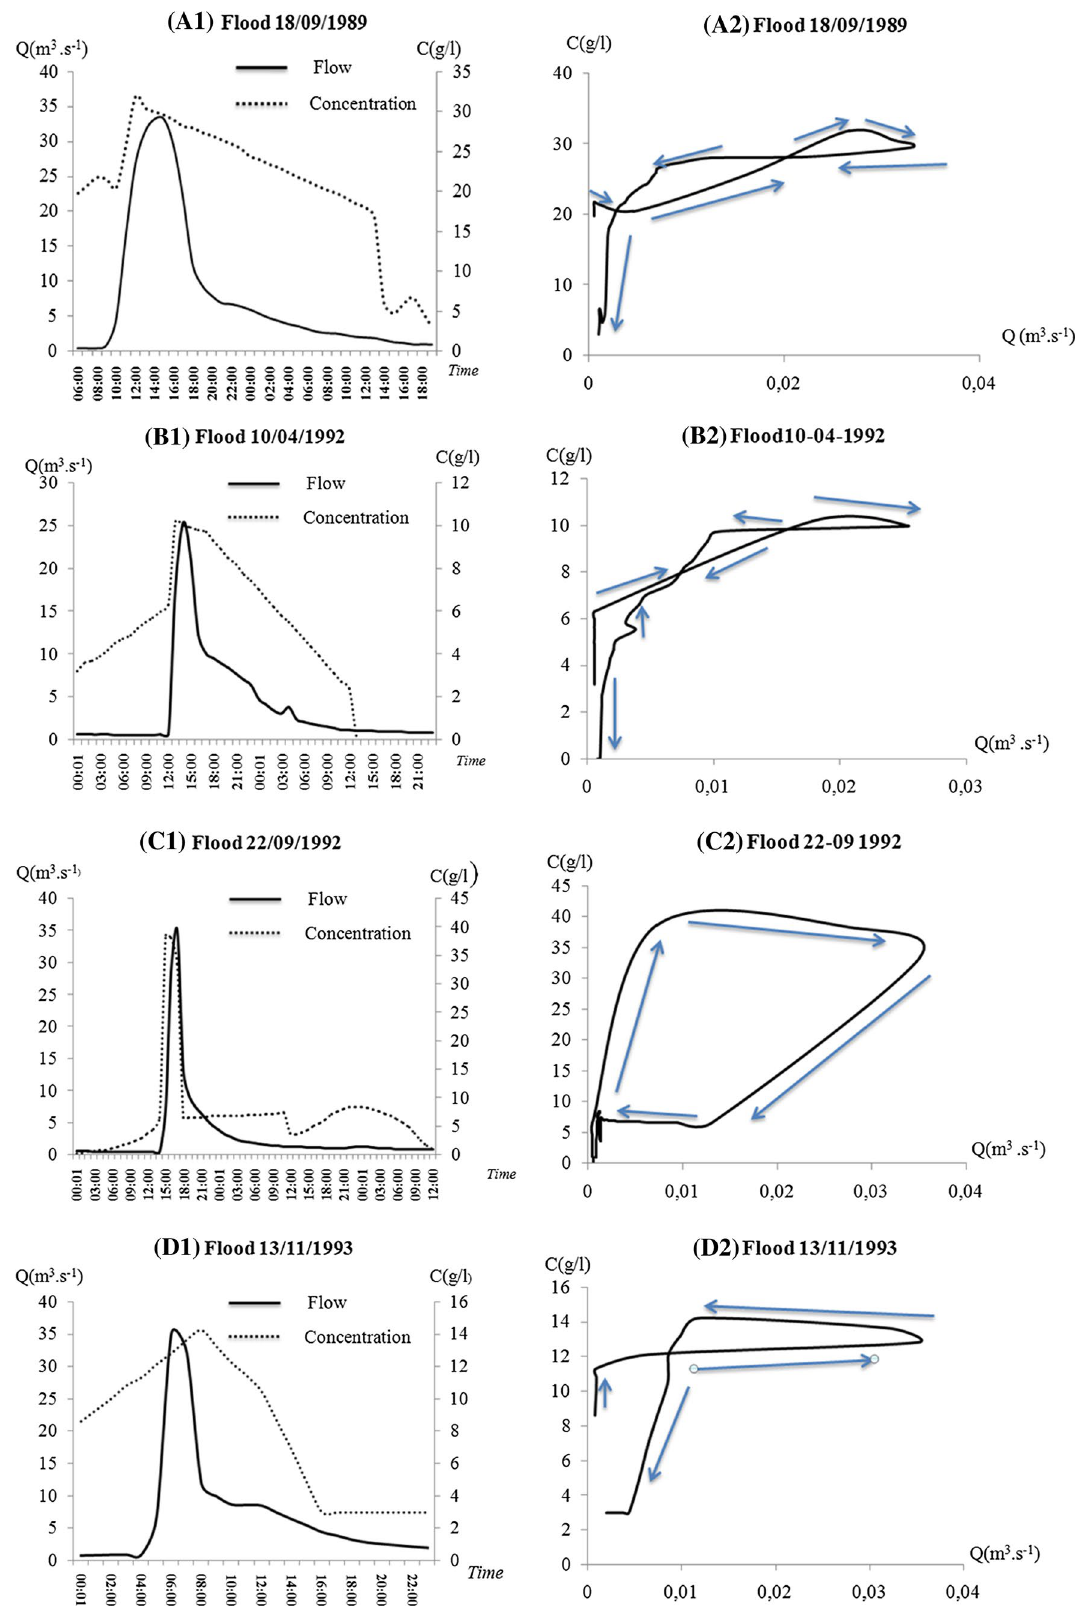
Fig. 6 The variation of the concentration as a function of the liquid flow rates in the form of